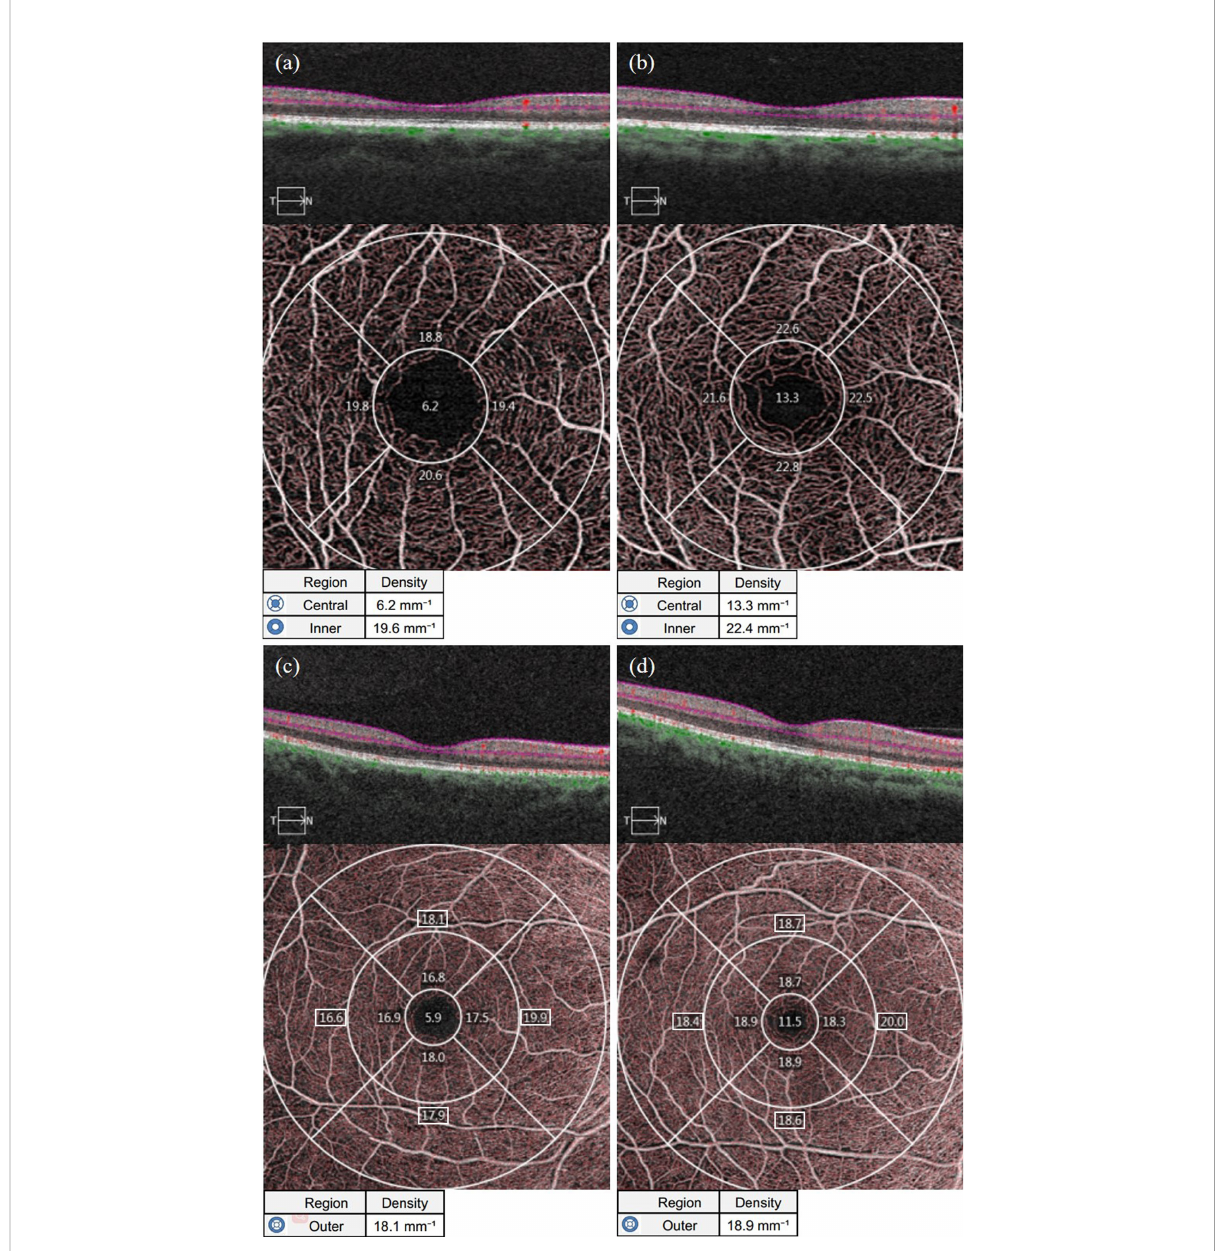
FIGURE 3 Representative OCTA images of VLD measurements in the macular area of the affected eyes in the NDR group and the tested eyes in the control group. (A) Results of OCTA macular area 3 mm×3 mm B scan, the en face image of the super fi cial retina and VLD of the foveal area (central item in the table, the same below), mean VLD of the parafoveal area (inner item in the table, the same below), and VLD in each quadrant of the parafoveal area (The corresponding quadrant number in the fi gure, the same below) automatically measured by the system software of the right eye of a 63-year-old female NDR patient. (B) Results of OCTA macular area 3 mm×3 mm B scan, the en face image of the super fi cial retina and VLD of the foveal area, mean VLD of the parafoveal area, and VLD in each quadrant automatically measured by the system software of the right eye of a 54-year-old female control. (C) Results of OCTA macular area 6 mm×6 mm B scan, the en face image of the super fi cial retina and VLD of the foveal area (outer item in the table, the same below), mean VLD of the parafoveal area, and VLD in each quadrant of the parafoveal area (The corresponding region number in the fi gure, the same below) automatically measured by the system software of the right eye of NDR patients as in (A) . (D) Results of OCTA macular area 6 mm×6 mm B scan, the en face image of the super fi cial retina and mean VLD of the parafoveal area, and VLD in each quadrant of the parafoveal area automatically measured by the system software of the right eye of the control as in (B) . The VLD results in the macular area of the NDR patients were smaller than those of the normal control. NDR, diabetes mellitus without diabetic retinopathy; VLD, vessel length density; OCTA, optical coherence tomography